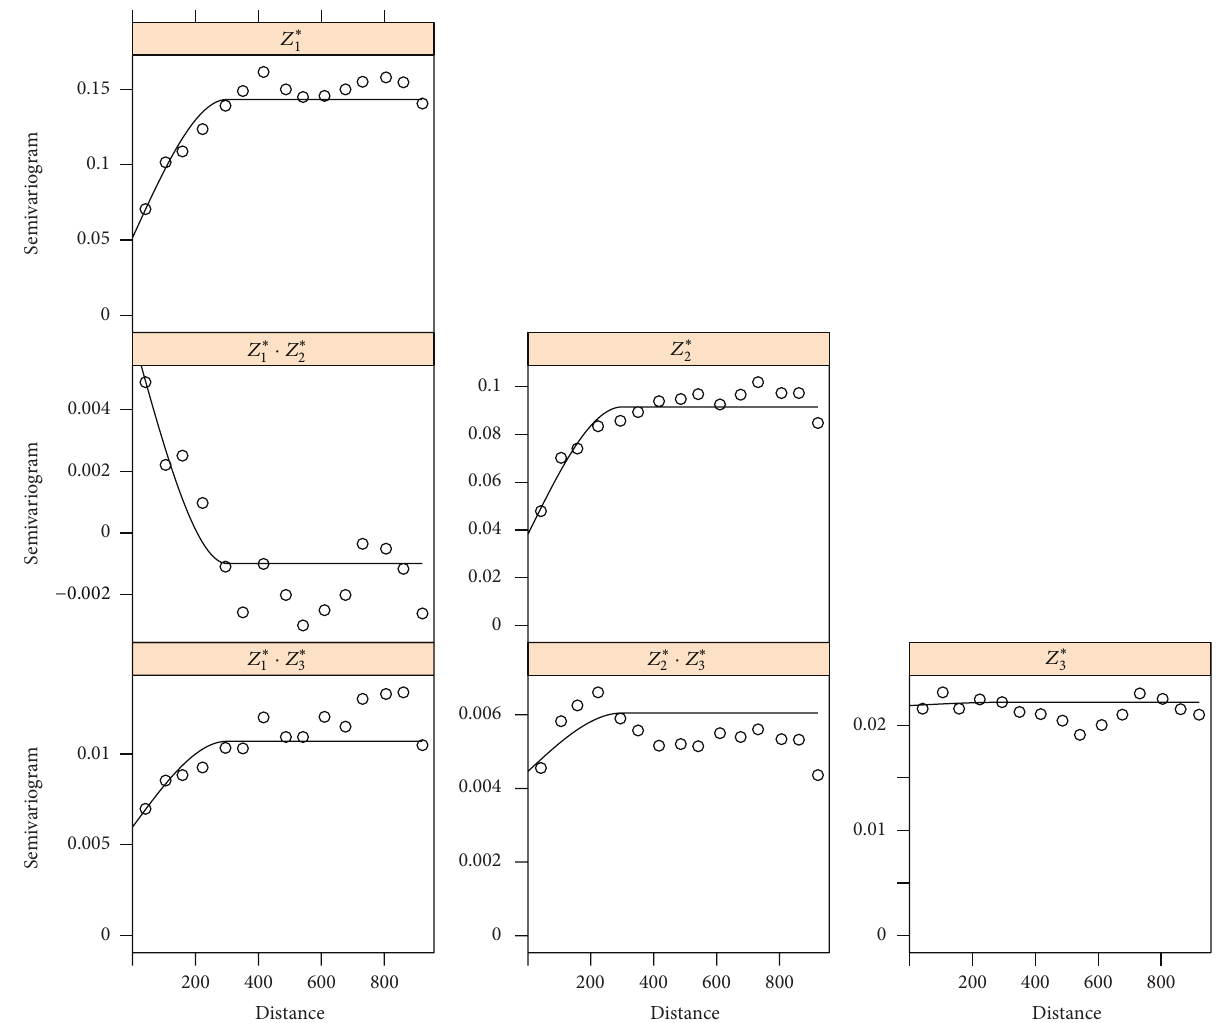
Figure 3: Experimental semivariograms (circles) together with the fitted theoretical semivariograms (lines) that describe the spatial correlation between the variables 𝑍 ∗ 𝑗 , 𝑗 = 1,2, 3